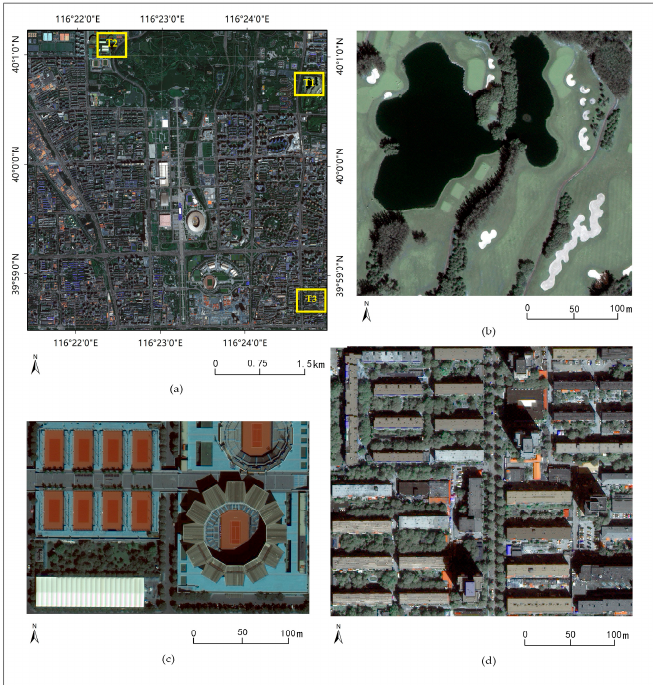
Figure 5. The WorldView-3 scene of study area ( a ); and subscenes: T1 ( b ); T2 ( c ); and T3 ( d ) used as the experimental data. The images are shown with a combination of red, green, and blue spectral bands.